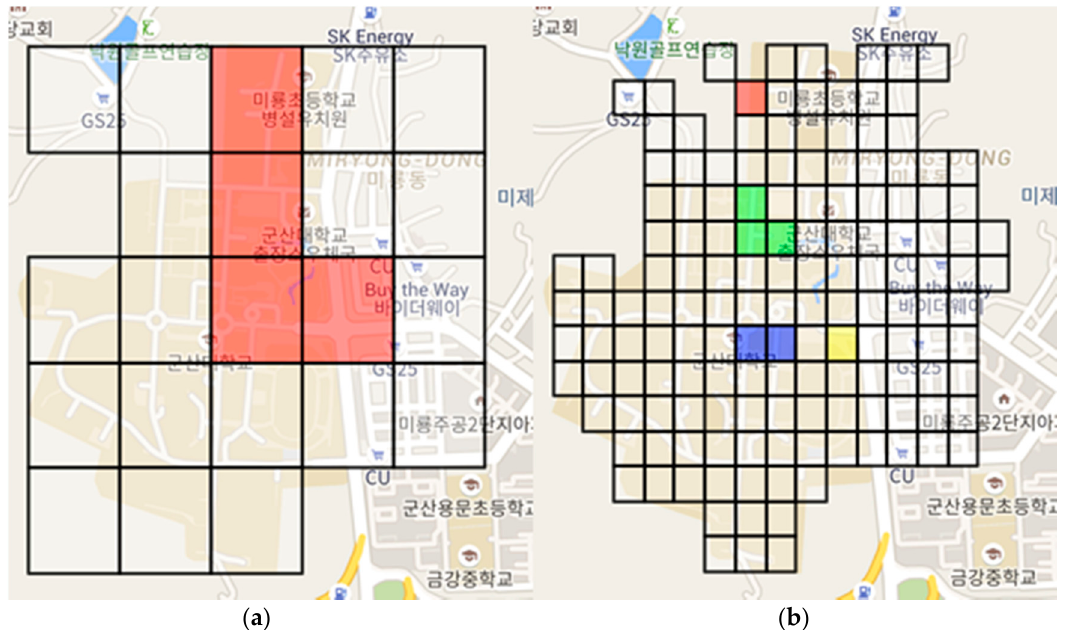
Figure 8. Teaming situation for SKTelecom: ( a ) 5 × 5 grids and ( b ) 15 × 15 grids.